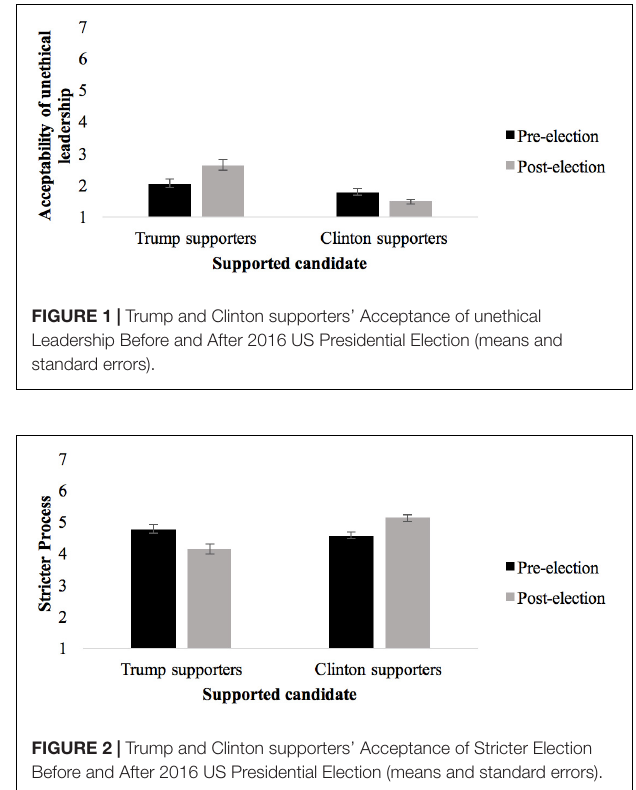
t (134) = 3.62, p < 0.001, g = 0.29, CI [0.05, 0.53]. Thus, H4a and H4b were supported for this variable (cf. Figure 1